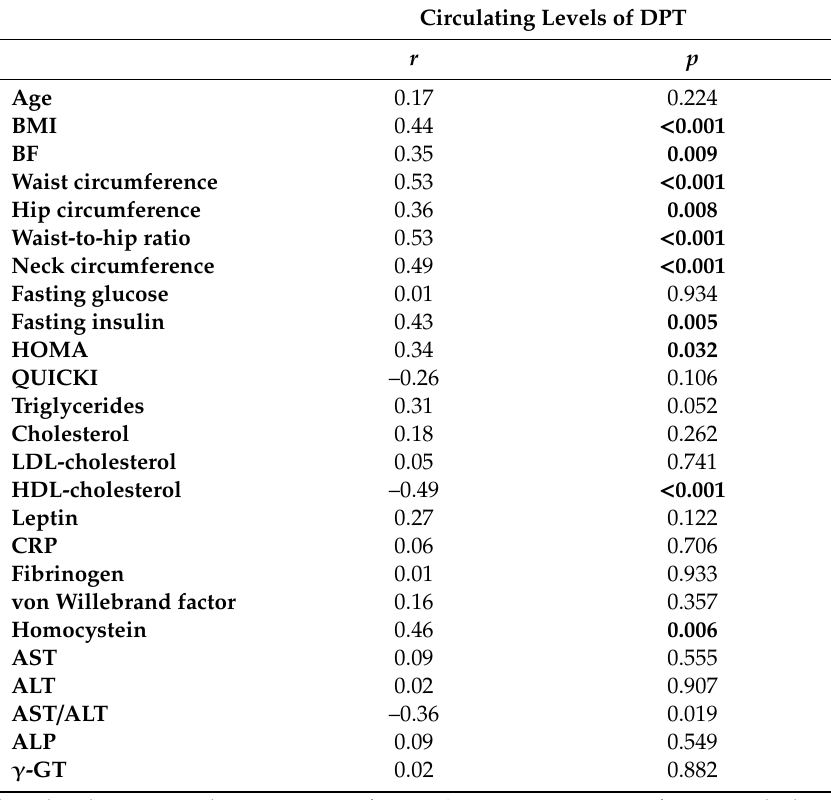
Table 2. Univariate analysis of the correlations between circulating levels of dermatopontin (DPT) with anthropometric measurement and biochemical